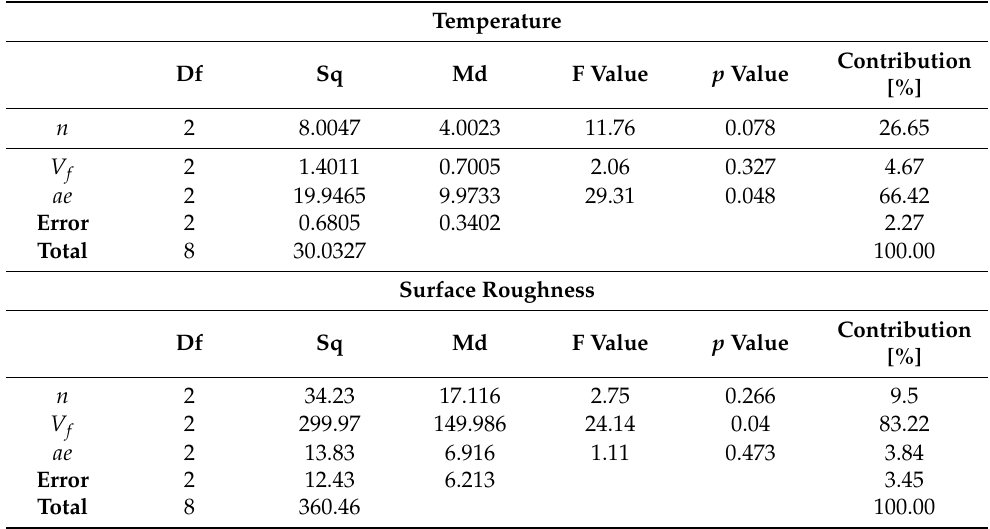
Table 12. ANOVA analysis for chip temperatures and surface roughness of the workpiece after machining tests with Balis Mafcool 51 (50